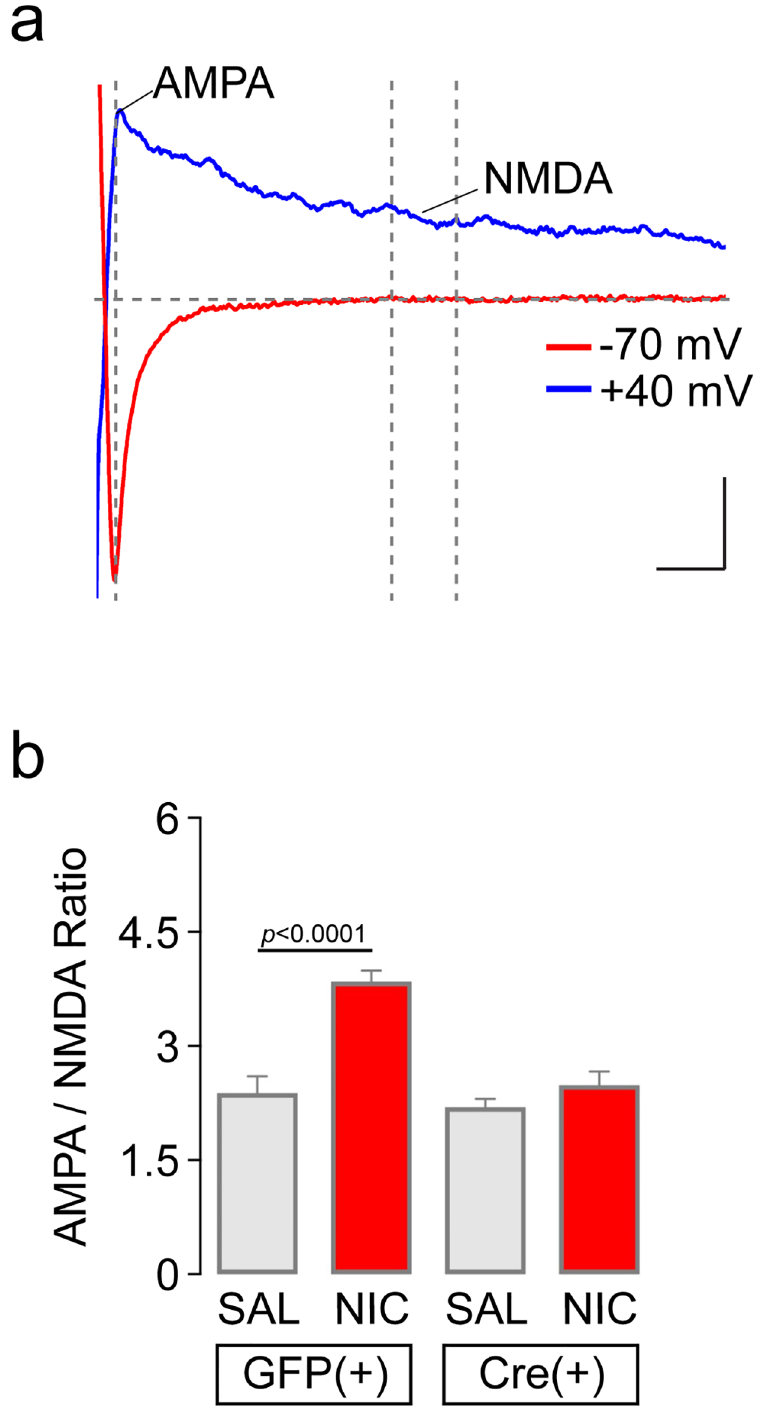
Fig 5. Reduced AMPA/NMDAratios in α 4-flox;Cre(+) VTA DA neurons. a) AMPA/NMDA ratios were measuredas describedin Materials and Methods. A representative evoked synaptic current in a neuron voltageclampedat -70 mV and +40 mV is shown. b) Quantificationof AMPA/NMDA ratios. In each VTA DA neuronfrom α 4-flox;Cre(+) and GFP(+) mice injectedwith saline(SAL) or nicotine (NIC; 0.17 mg/kg), mean ( ± SEM) AMPA/NMDA ratio is shown. Replicatecells and number of animals: GFP(+) SAL, n = 8 cells, n = 3 animals; GFP(+) NIC, n = 16 cells, n = 5 animals; Cre(+) SAL, n = 8 cells, n = 3 animals; Cre(+) NIC, n = 7 cells, n = 2 animals. **** p < 0.0001 (Bonferroni’s multiple comparisontest followingtwo-way ANOVA).